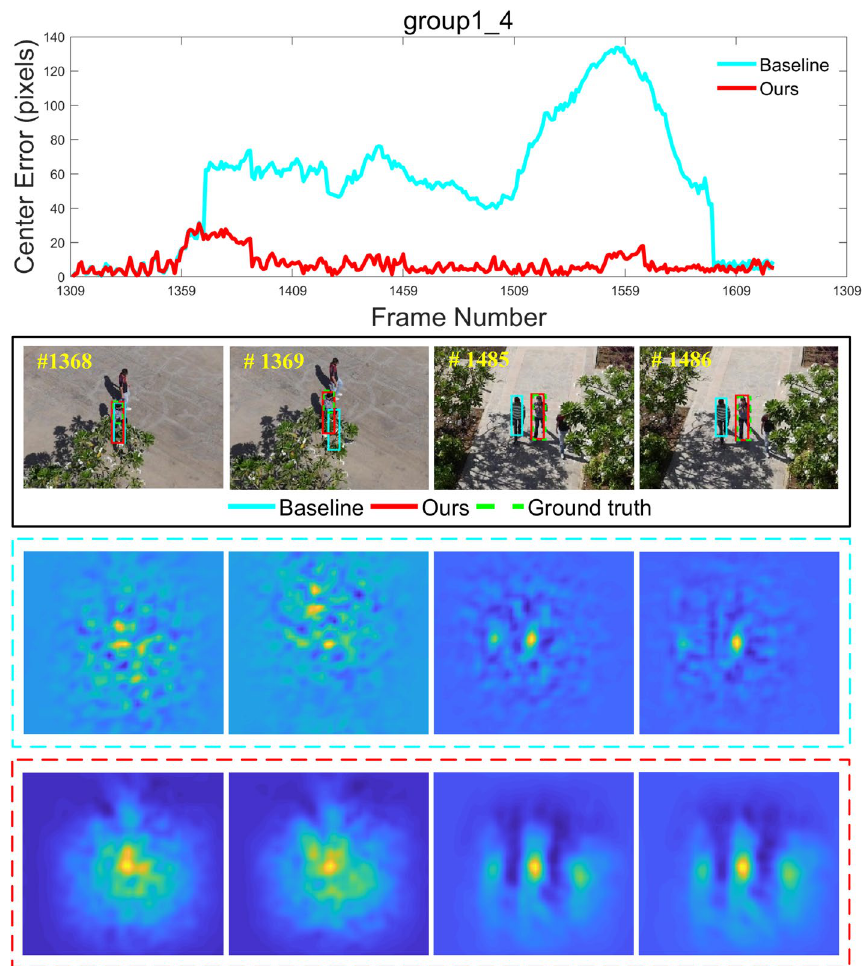
Fig. 2 Comparison of the proposed method with the baseline SRDCF tracker on the group4_1 sequence from public UAV benchmark dataset. From top to bottom are a frame-by-frame comparison of the center location error (in pixels), tracking results of baseline tracker (cyan), the proposed method (red), and the ground truth (green dot), the response maps of the baseline SRDCF tracker and the response maps of the proposed